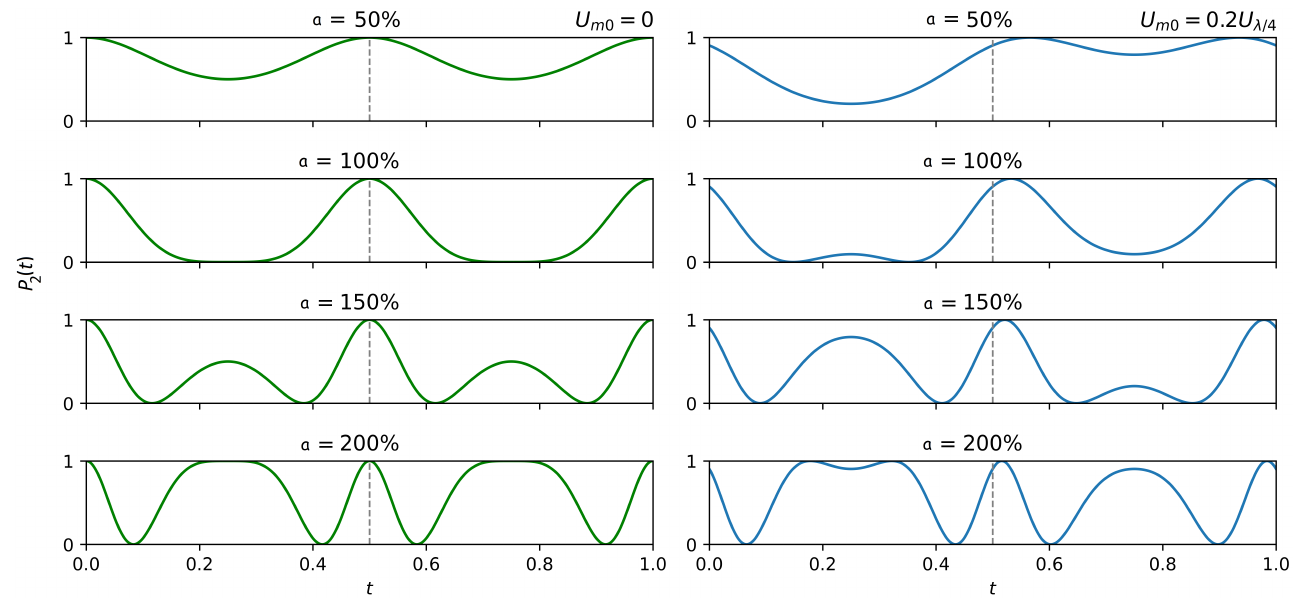
Figure 4. Transmission P 2 ( t ) for bias voltage U m 0 / U λ /4 = 0 ( left ) and 0.2 ( right ) at a = 50,100,150,200%, k = 2. Time t is in units of the resonator round-trip time T r (color